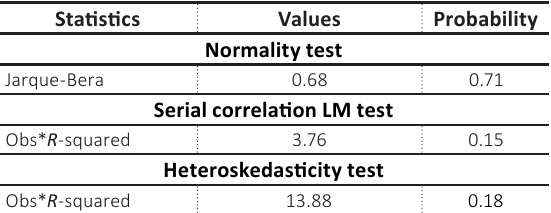
Table 8. ARDL diagnostic